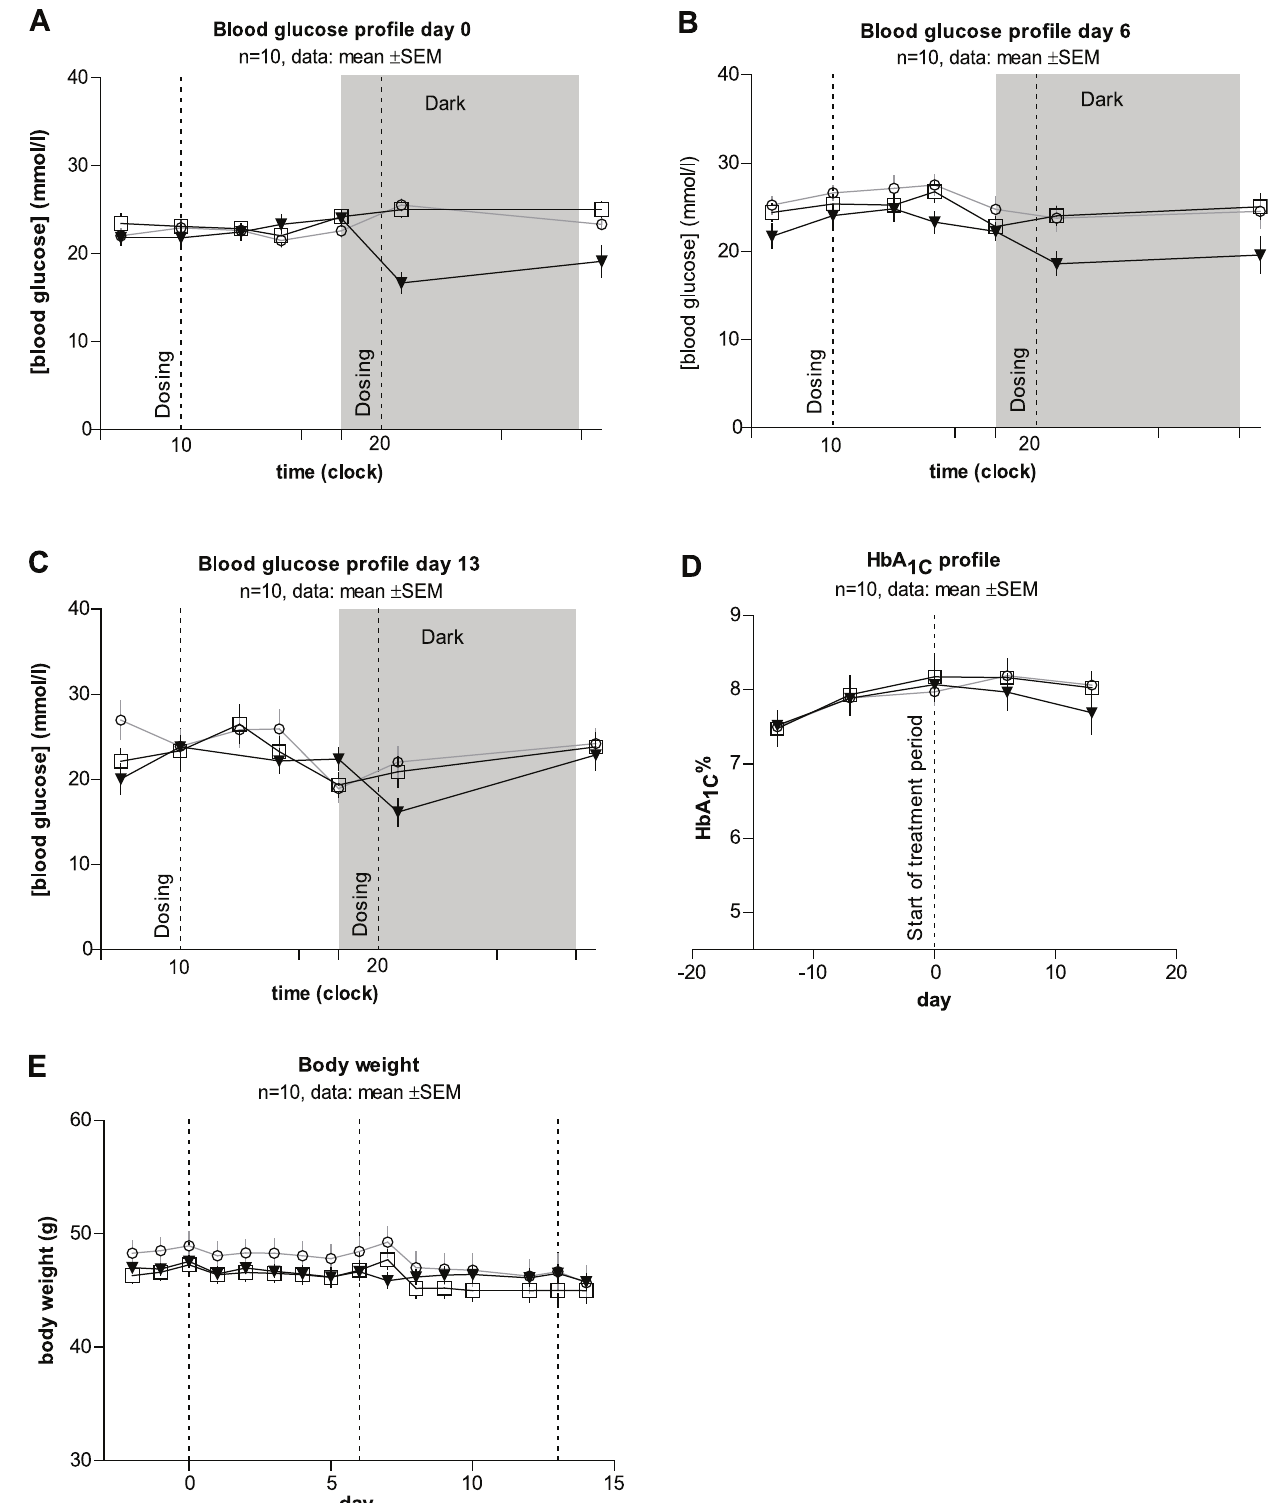
Figure 5. Invivo effects of hAd on glycaemic control in diabetic db/db mice. The animals were dosed intraperitoneally once daily with metformin (closed triangles) or twice daily with hAd (open squares) or vehicle (open circles) for 14 days. Blood glucose profiles were taken at day 0 ( A ), day 6 ( B ) and day 13 ( C ) of the study at 7 a.m., 10 a.m., 1 p.m., 3 p.m., 6 p.m., and 9 p.m. HbA 1c ( D ) was measured on the same days and additionally 7 and 14 days before the start of dosing. Body weight ( E ) was monitored daily. The data is representative for all studies performed with db/db mice. The data for all other forms of adiponectin is summarized in Table 2.